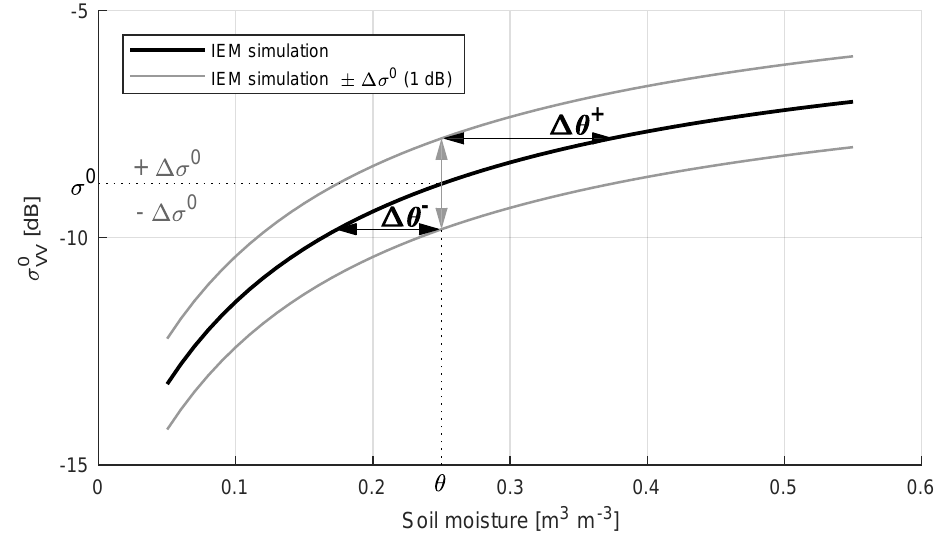
Figure 2. Illustration of the method to estimate the impact on soil moisture retrievals ( ∆ θ ) at a specific soil moisture value ( θ ) due to a deviation ( ∆ σ 0 ) in VV backscatter ( σ 0 between σ 0 and soil moisture simulated by IEM. This example uses the surface roughness parameters VV representative for meadows, listed in Table